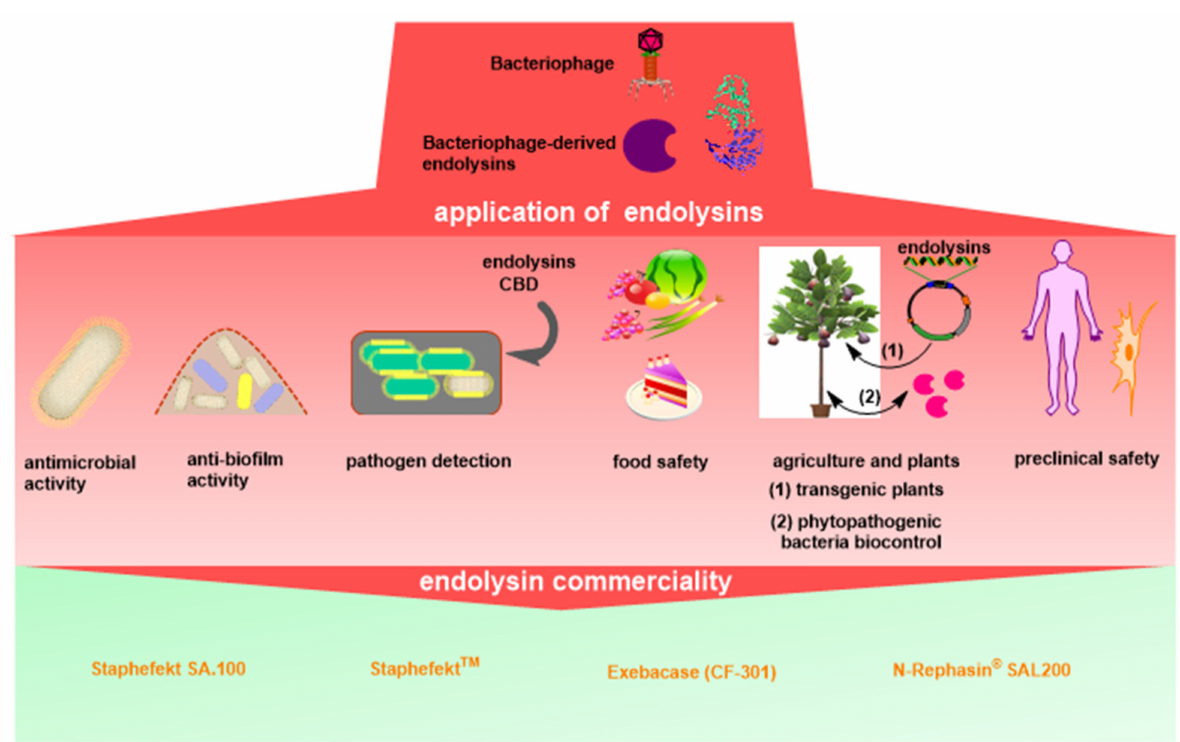
Figure 2. Graphical summary of phage endolysin applications as promising antimicrobial